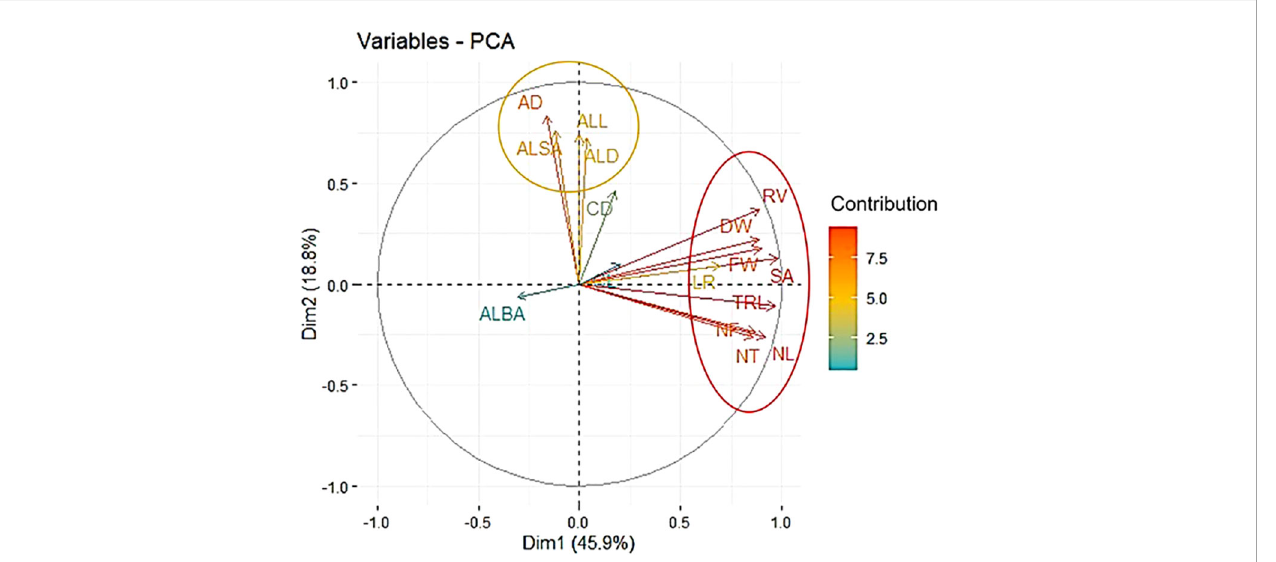
FIGURE 2 Root system architecture trait principal component biplot. The fi rst (Dim1) and second (Dim2) principal component dimensions are in x and y-axis respectively. Red and orange ovals represent clusters formed. Vector color represents the percent contribution of each individual trait to the fi rst and second principal